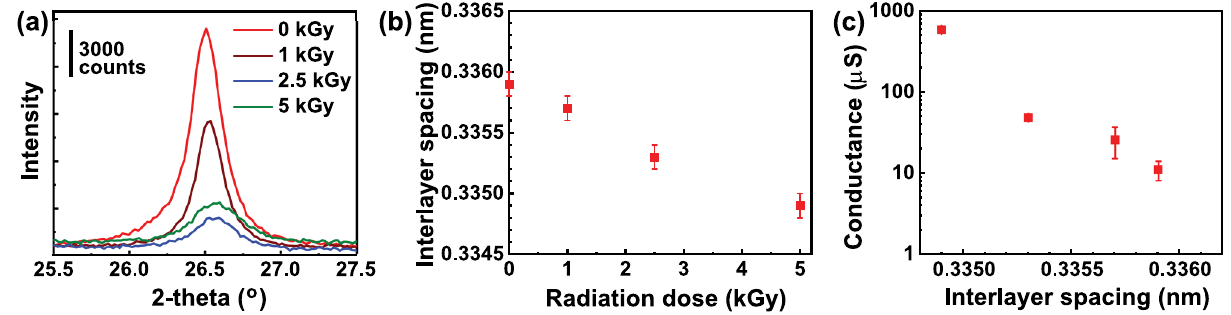
Figure 3. XRD spectroscopy analysis. ( a ) (002) peak of XRD spectra of GnF samples with varying gamma-ray radiation doses of 0.0, 1.0, 2.5, and 5.0 kGy. ( b ) Interlayer spacing of GnFs as a function of radiation dose. ( c ) Semi-log plot of electrical conductance as a function of interlayer spacing for GnFs. Exponential increase of conductance is observed as interlayer spacing is reduced.